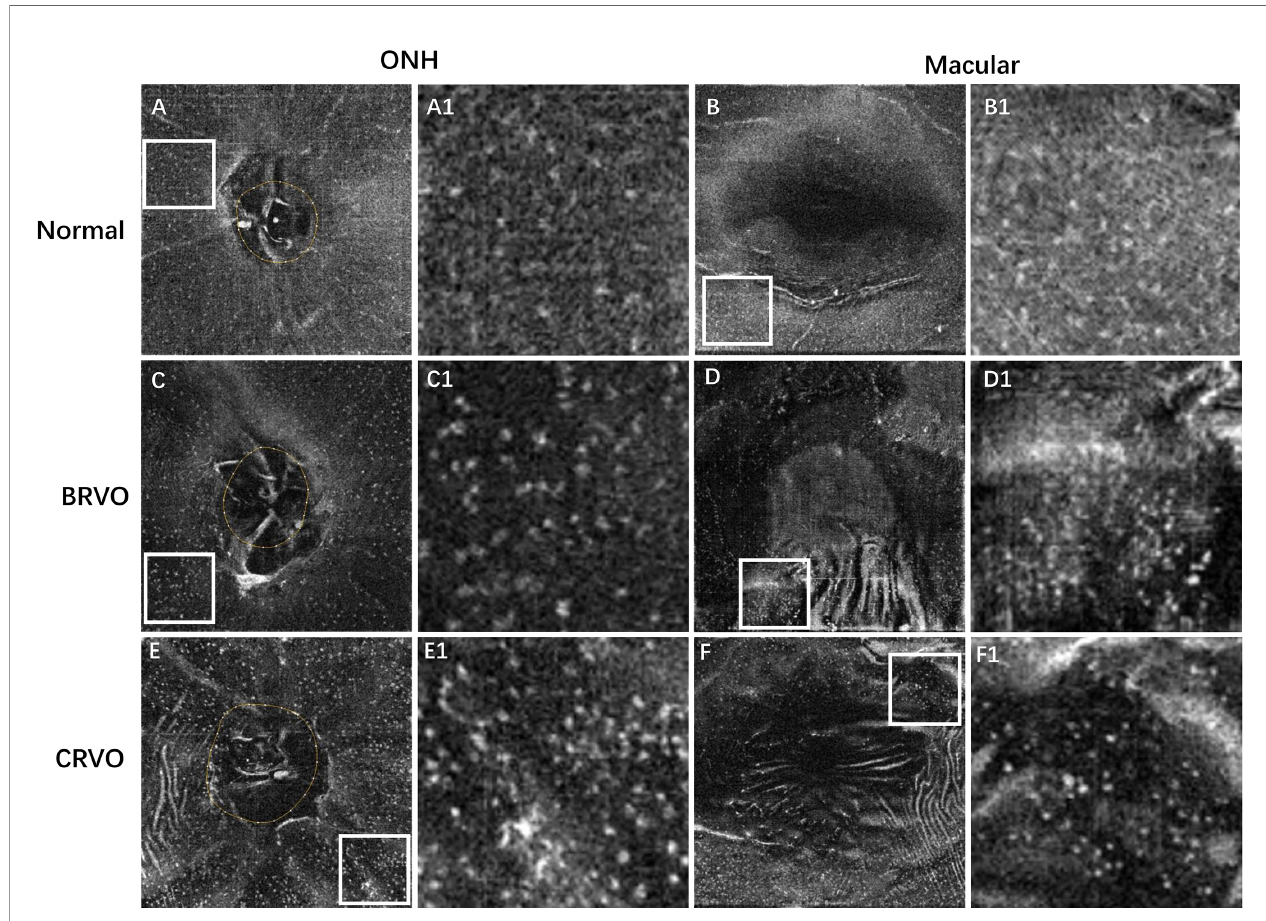
FIGURE 2 | Representative examples showing the cellular morphology in a normal eye ( fi rst row), a patient with BRVO (second row), and a patient with CRVO (last row). The fi rst and second columns show the en face OCT of the ONH and macular regions, respectively. The regions of interest (ROI) with relatively higher cell densities in 4.5 × 4.5 mm ONH region and 6 × 6 mm macular region were indicated by white box. The ROI was enlarged by 4 times and shown at the right side of the original fi gures. The MLCs appear larger and plumper with fewer protrusions in eyes with RVO. BRVO, branch retinal vein occlusion; CRVO, central retinal vein occlusion; OCT, optical coherence tomography; ONH, optic nerve head; MLCs, macrophage-like